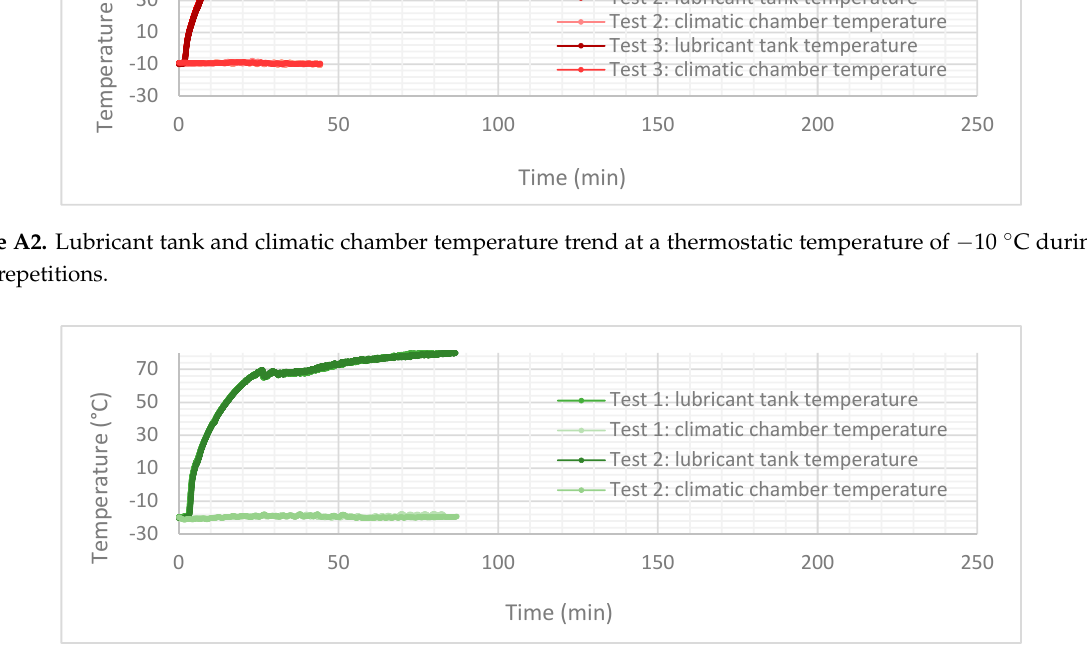
Figure A3. Lubricant tank and climatic chamber temperature trend at a thermostatic temperature of − 20 °C during the two repetitions.